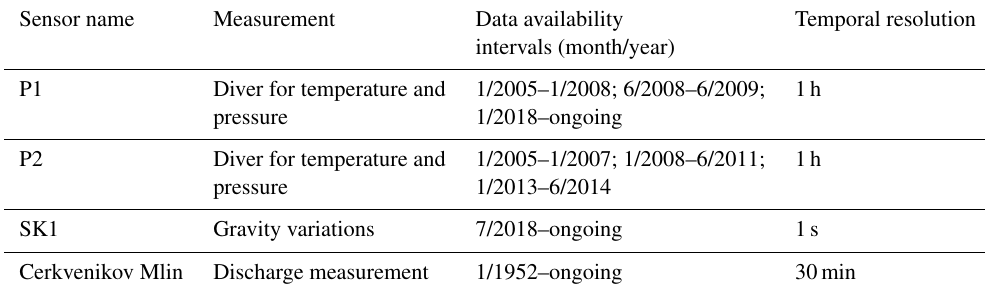
Table 1. Hydrologic and geophysical data availability in the Škocjan